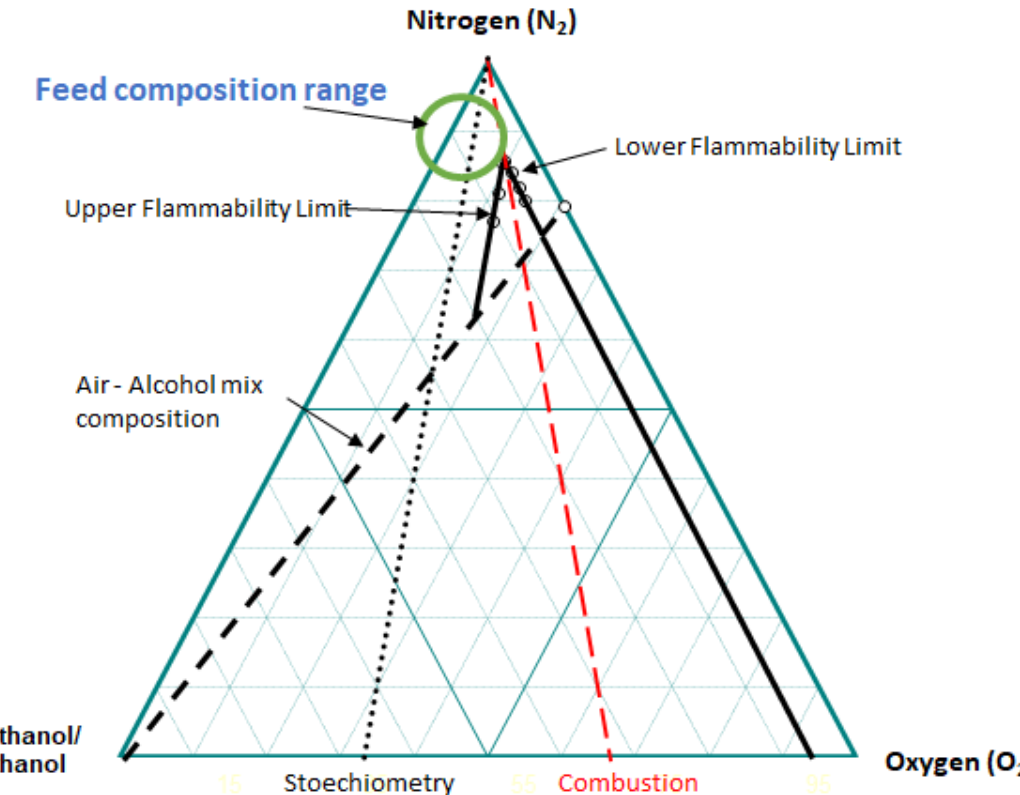
Figure 1. Flammability limits diagram at 25 °C for methanol and ethanol mix = 50%:50% molar ratio.